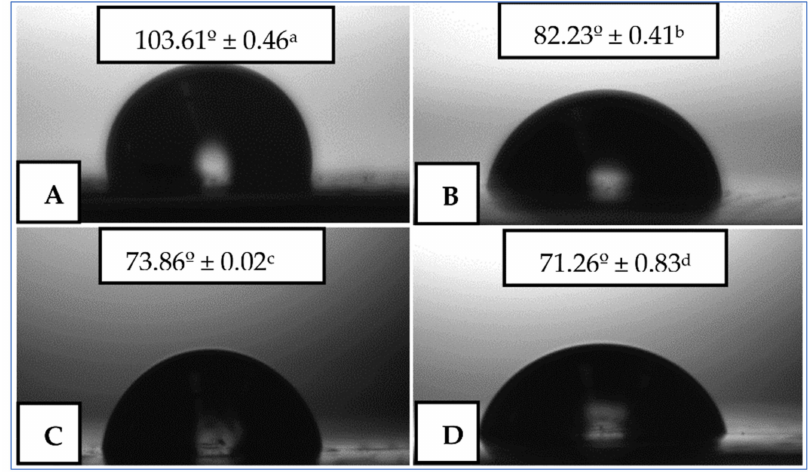
Figure 9. Water contact angle of the electrospun films of: ( A ) Neat poly(3-hydroxybutyrate-co-3- hydroxyvalerate) (PHBV); ( B ) Oregano essential oil (OEO)-containing PHBV; ( C ) Rosemary extract (RE)-containing PHBV; ( D ) Green tea tree extract (GTE)-containing PHBV. Reproduced from Ref.